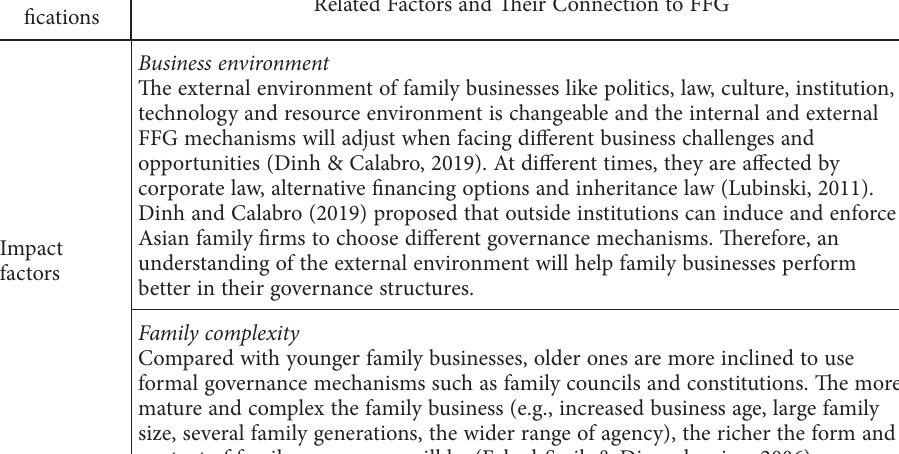
Related Factors and Their Connection to FFG